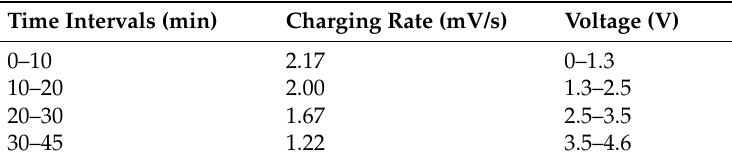
Table 3. Charging rate for the 50 F supercapacitor.